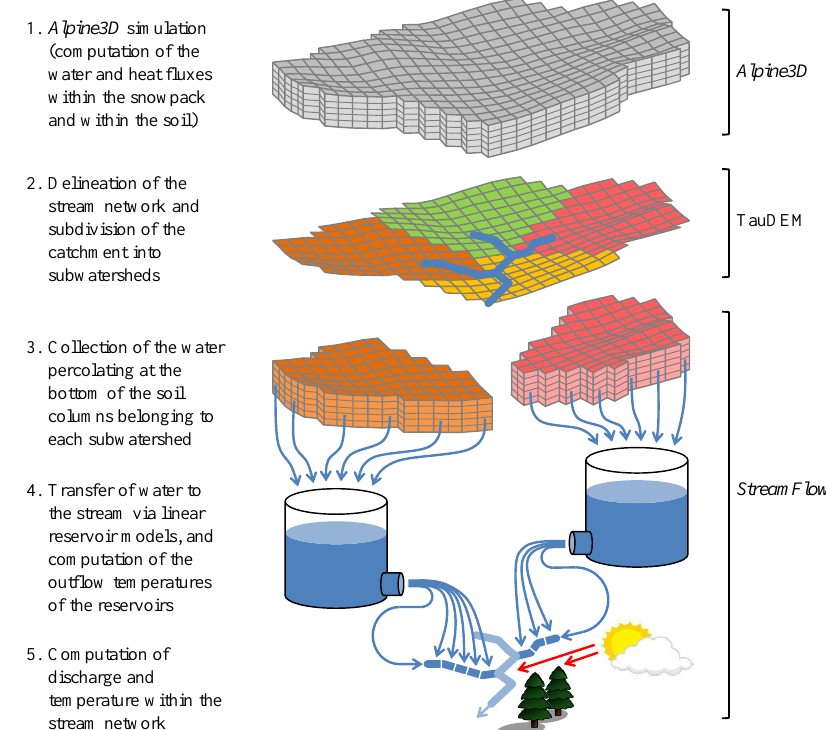
Figure 1. Schematic representation of the work flow in StreamFlow. Note that the first two steps are not performed in StreamFlow itself but in Alpine3D and with the help of TauDEM,